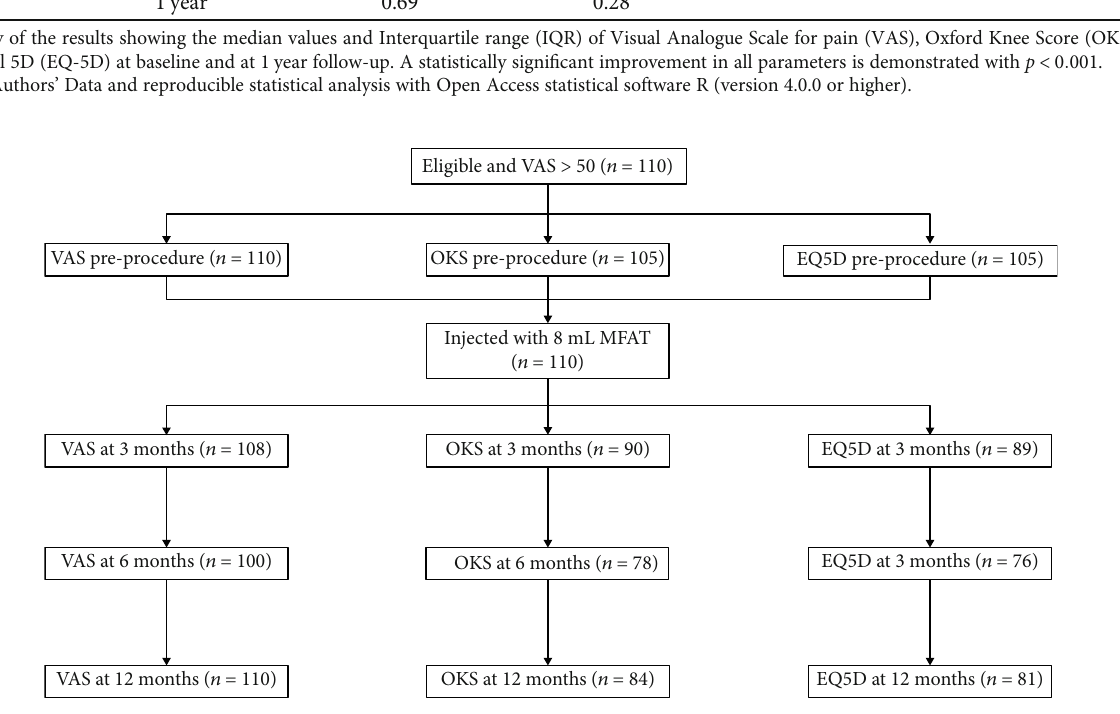
Figure 5: Study fl ow diagram depicts the touch points including the preprocedure assessment, injection of the knee, and subsequent follow-up and attrition in the collection of outcomes.